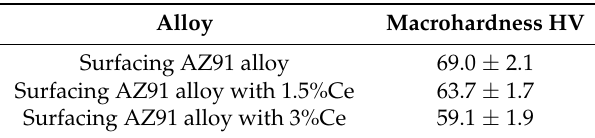
Figure 4. The measured and calculated X-ray diffractogram of the surfacing alloys. ( a ) surfacing AZ91 alloy with 0% Ce; ( b ) surfacing alloy with 1.5% Ce; ( c ) surfacing alloy with 3% Ce. Table 2. Microhardness of the tested surfacing alloys.